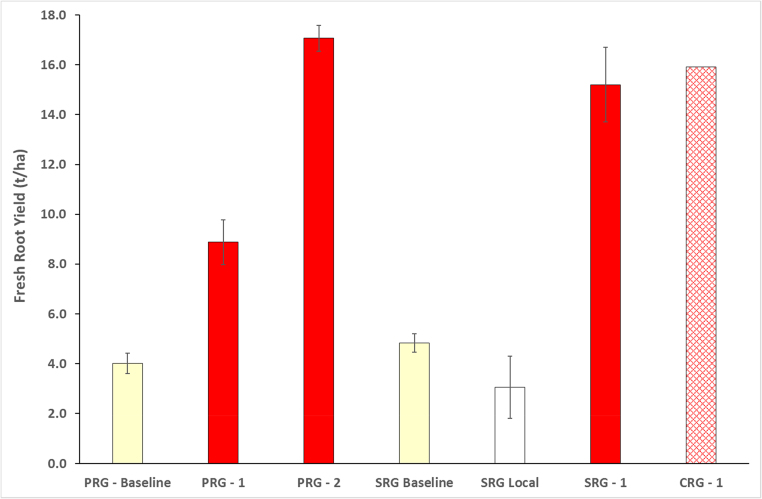
Fresh root yields recorded from farmer groups in Mkuranga for PRG, SRG and CRG plantings. The SRG local fields were cultivated with local varieties and monitored in parallel with PRG Kiroba fields prior to the start of community phytosanitation in the SRG area.